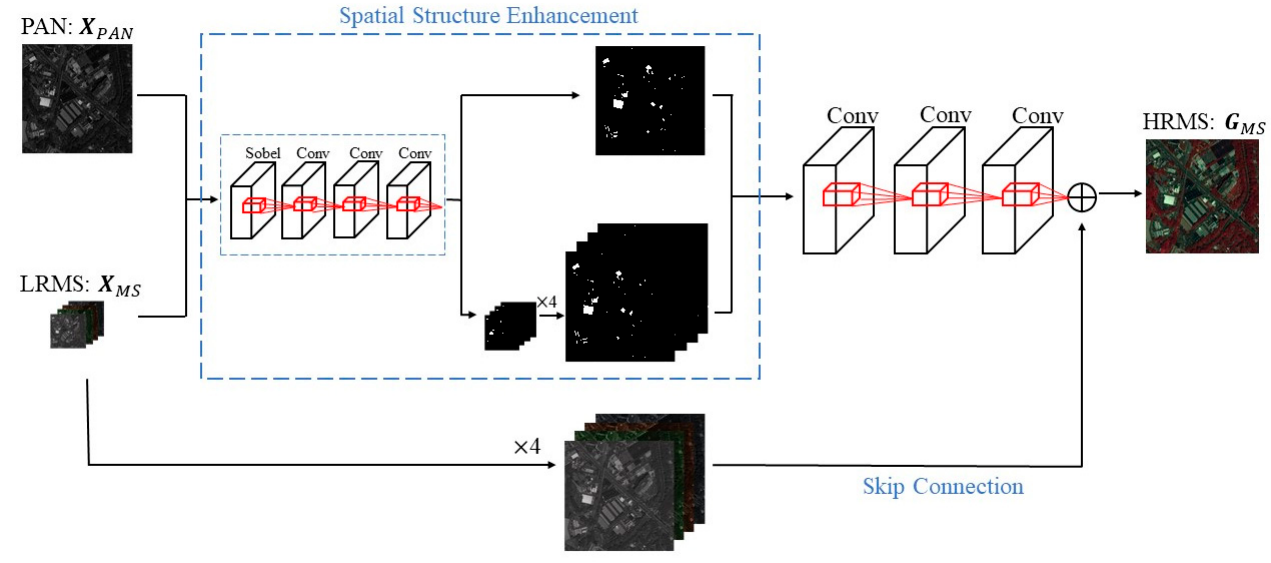
Figure 3. Architecture of the proposed method.